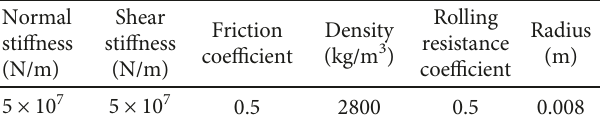
Table 2: Mesomechanical parameters of the particles.